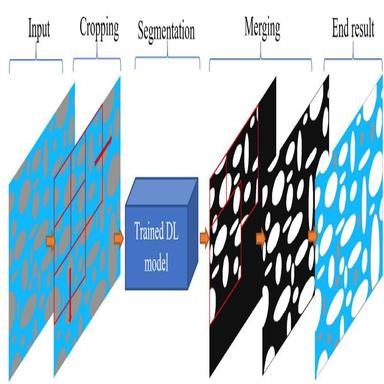
A schematic illustrating the regional instance segmentation approach. Input image of the microstructure is split into patches using the sliding window algorithm and the patches are fed into the trained DL model. The segmented patches from the model are then merged together. Finally, the input image is added pixel wise to obtain the end result.